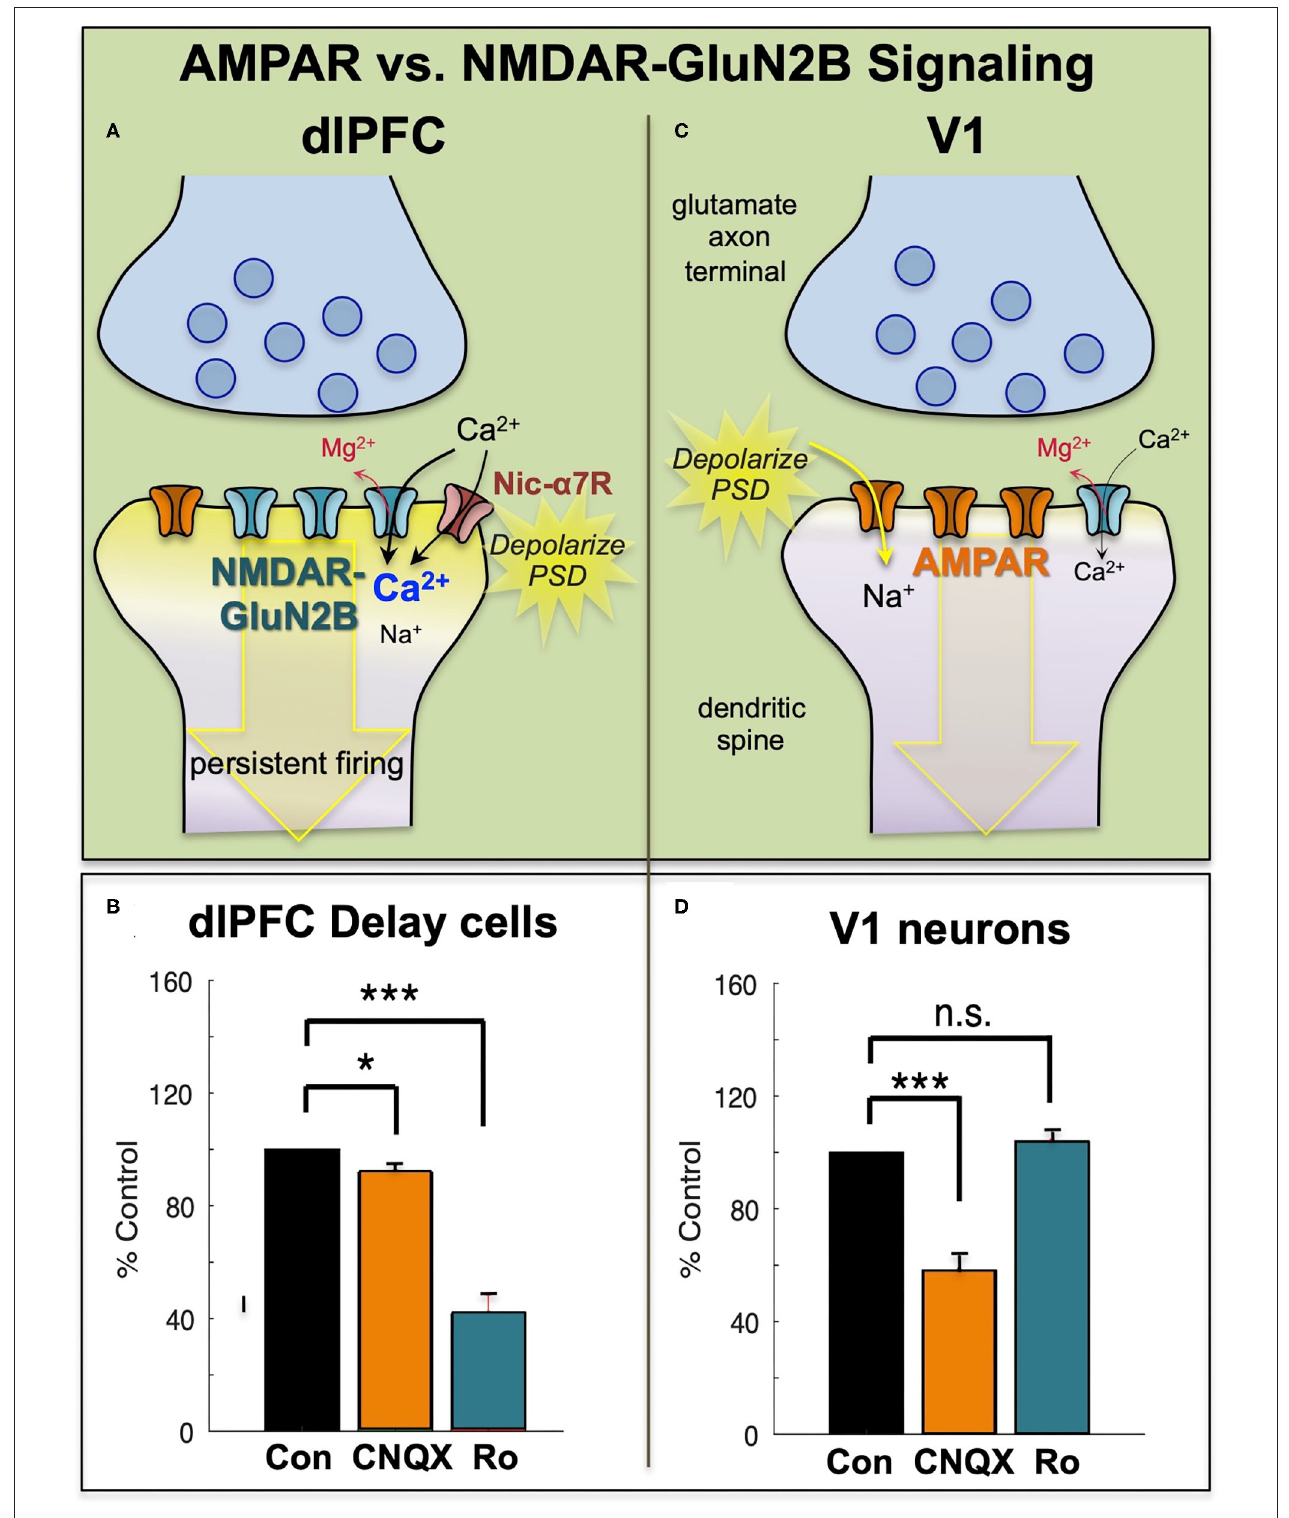
FIGURE 3 | The primate dlPFC and primary visual cortex (V1) have very different neurotransmission. (A) The dlPFC depends on NMDAR neurotransmission, including those with slowly closing GluN2B subunits, that are exclusively within the PSD. The permissive excitatory effects to relieve the magnesium (Mg 2 + ) block of the